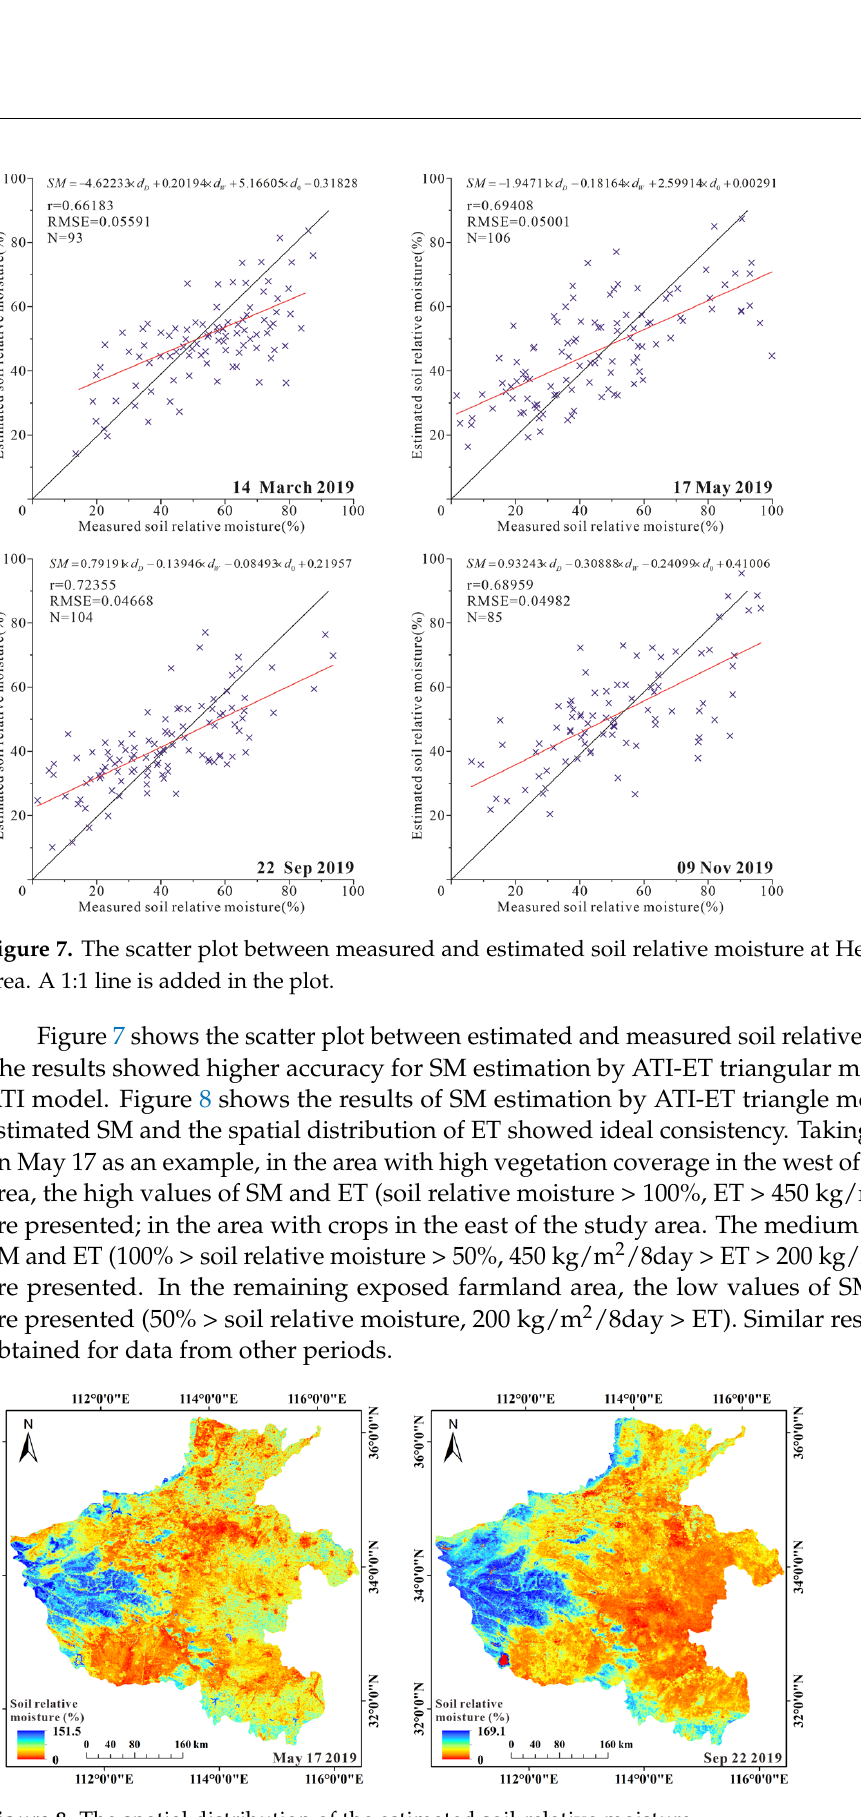
Figure 8. The spatial distribution of the estimated soil-relative